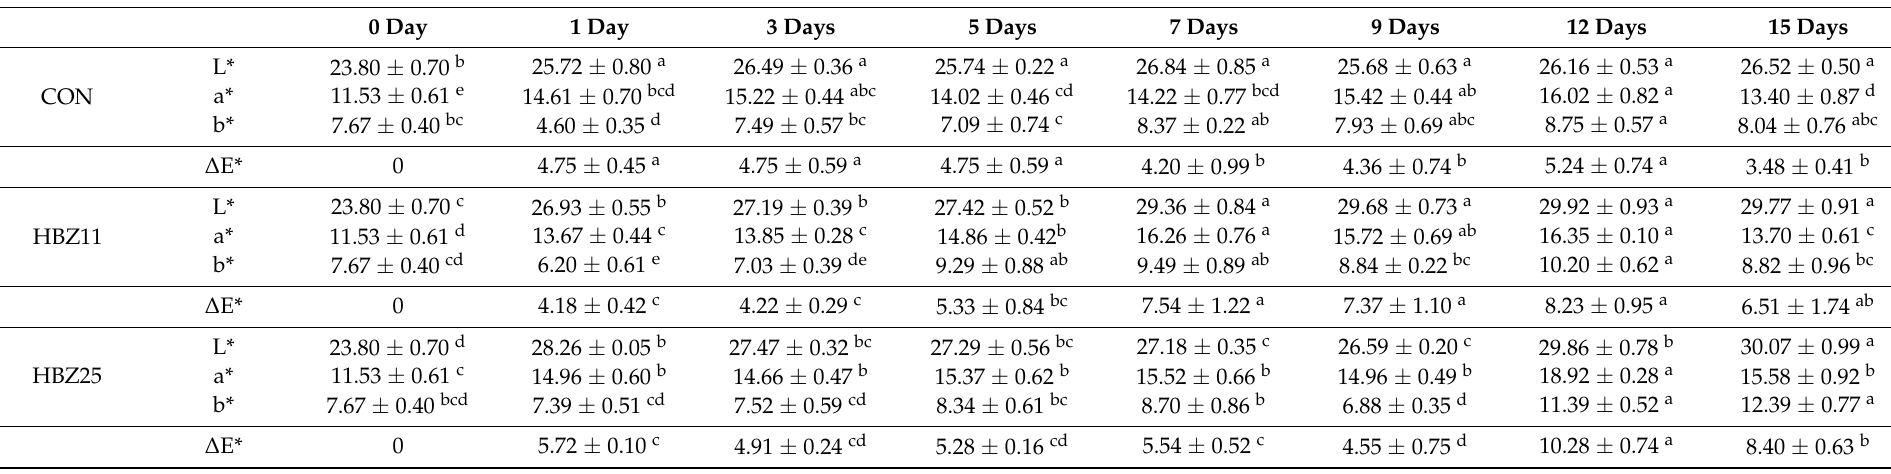
Table 2. Effects of fermentation on the changes of HST